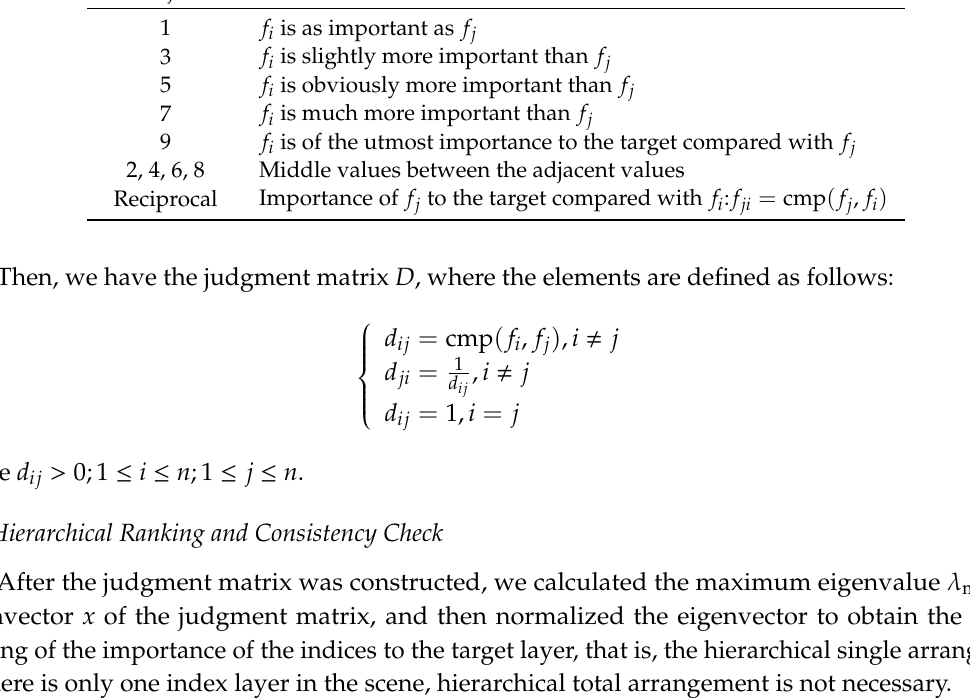
Table 2. Meaning of the analytic hierarchy process (AHP) scale. f